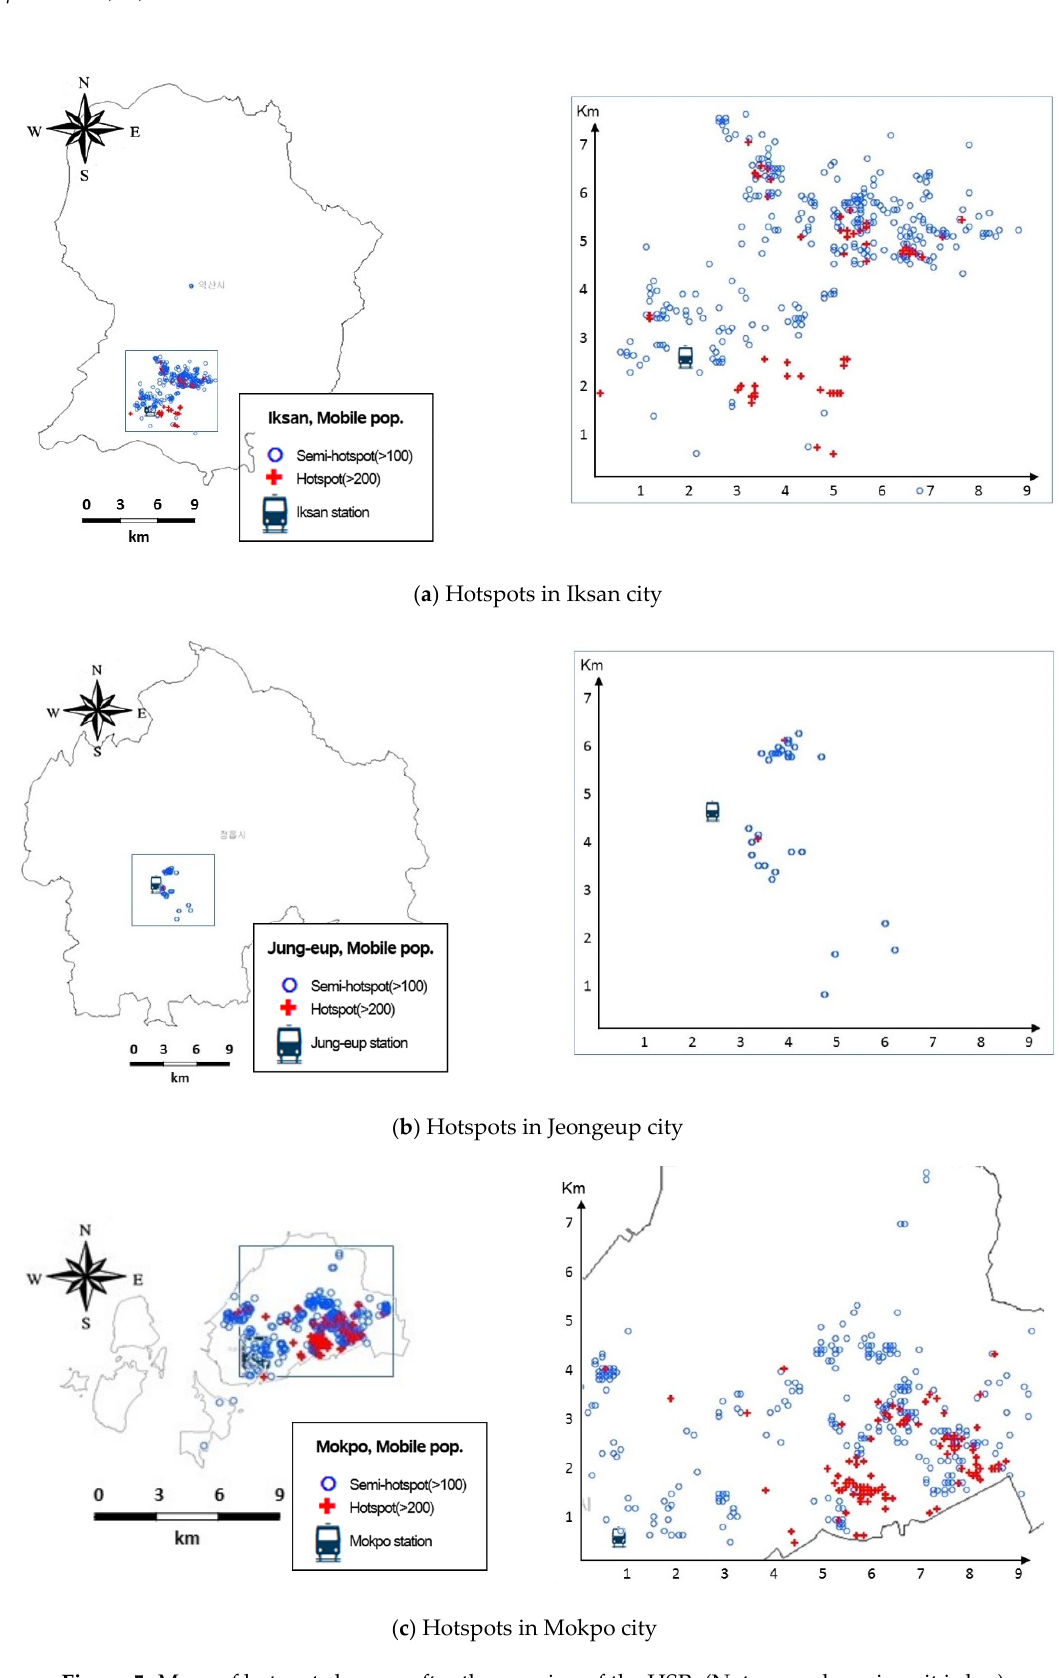
Figure 5. Maps of hotspot changes after the opening of the HSR. (Note: x and y-axis unit is km).